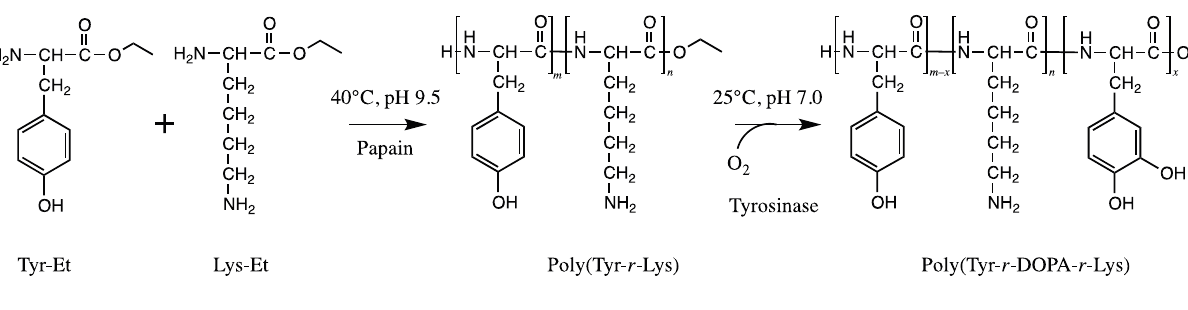
Figure 9. Two step chemoenzymatic synthesis of adhesive peptides containing DOPA and L